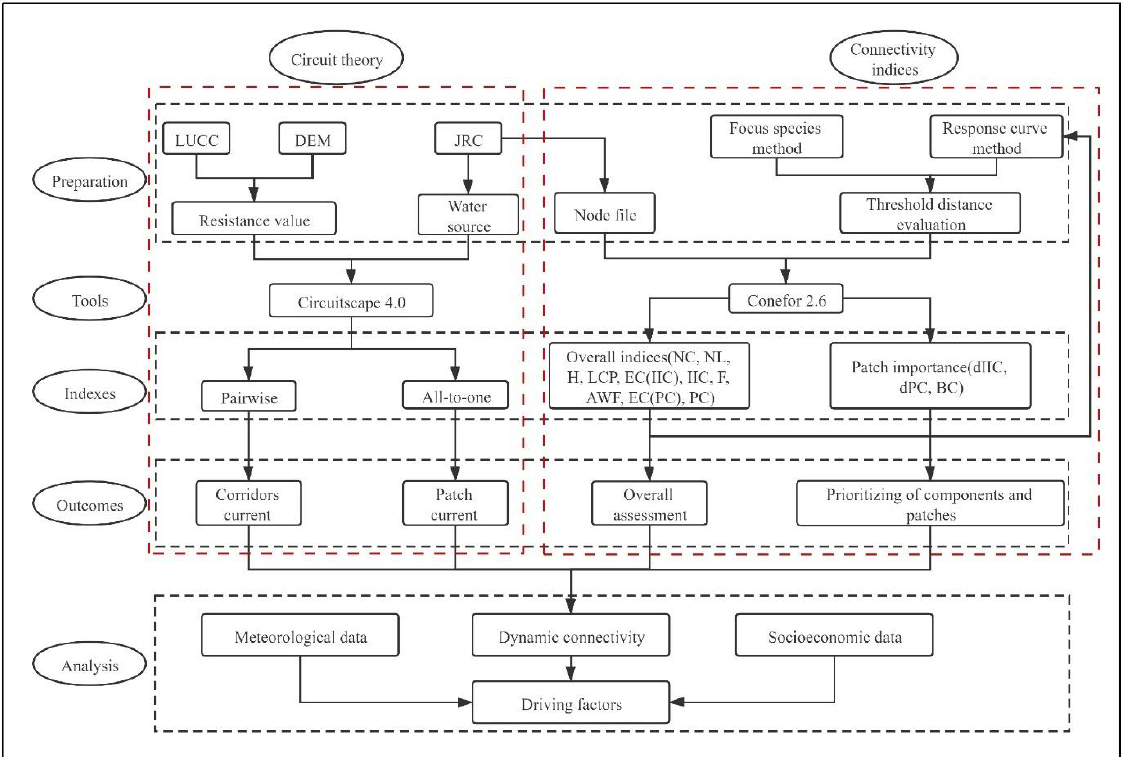
Figure 2. Diagrammatic representation of the approach used in the study.